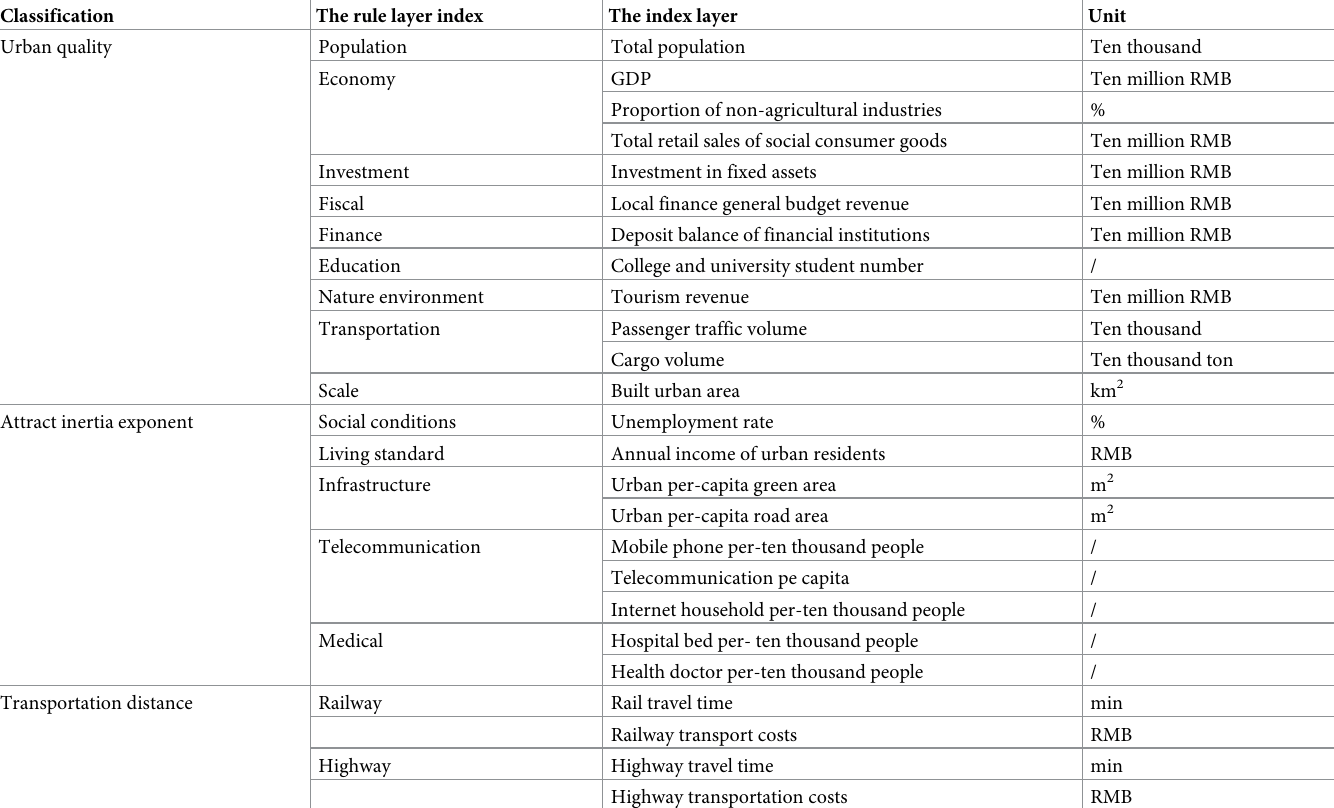
Table 1. Urban gravity index